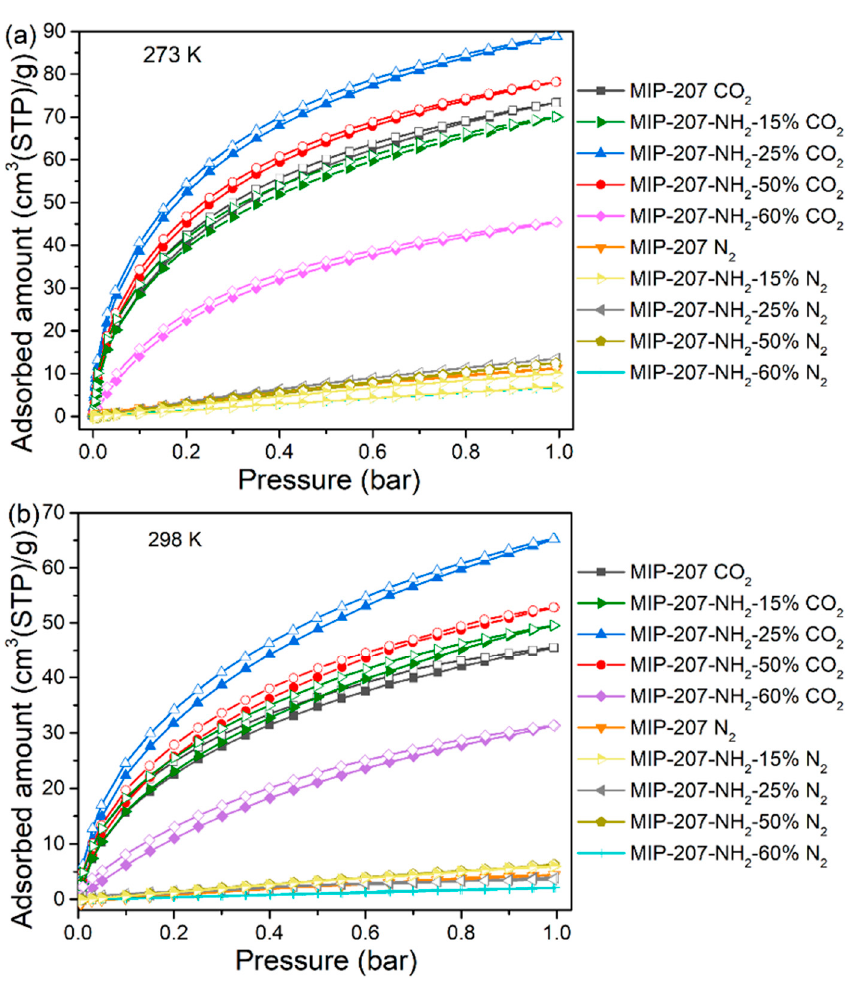
Figure 4. CO 2 and N 2 adsorption and desorption isotherms at ( a ) 0 °C and ( b ) 25 °C. To figure out the CO 2 adsorption separation performance, the selectivity of CO 2 /N 2 was calculated by the IAST model (Supporting Information). As shown in Figure 5a, compared with the separation factor of MIP-207 (59), the CO 2 /N 2 separation factor of MIP-207-NH 2 -15% was 69, which was 17% higher than that of MIP-207. Additionally, MIP-207-NH 2 -25% exhibited the highest CO 2 /N 2 separation factor (77), which was 33% higher than MIP-207, mainly because the introduction of the -NH 2 group into the MIP-207 channels could produce more adsorption sites, leading to an enhanced affinity toward CO 2 . However, the structure of MIP-207-NH 2 -60% possessed more -NH 2 and the separation factor of MIP-207-NH 2 -60% was only 22, illustrating that the spatial framework of MIP-207 in MIP-207-NH 2 -60% was destroyed, thus increasing the non-selective uptake. In addition to focusing on the adsorption and separation performance, it is also necessary to take energy consumption into account during the regeneration process in industrial applications [32]. The isosteric heat of CO 2 adsorption (Q st ) of the materials was obtained from the CO 2 adsorption isotherms at 0 ◦ C. As shown in Figure 5b, the MIP-207-NH 2 - n ( n = 15%, 25%, 50%) adsorbents had an isosteric adsorption heat of about 30–35 kJ mol − 1 , which exhibits a medium-strength interaction with CO 2 . It can also be found that the Q st of MIP-207-NH 2 -60% was significantly lower than that of the above four materials, which indicates that the framework structure of MIP-207-NH 2 -60% has a negative effect on the adsorption capacity of CO 2 . Considering that the MIP-207-NH 2 -25% exhibited superior CO 2 adsorption performance with a remarkable adsorption heat, a test of the cyclic stability of CO 2 was performed and the results are displayed in Figure 6. The CO 2